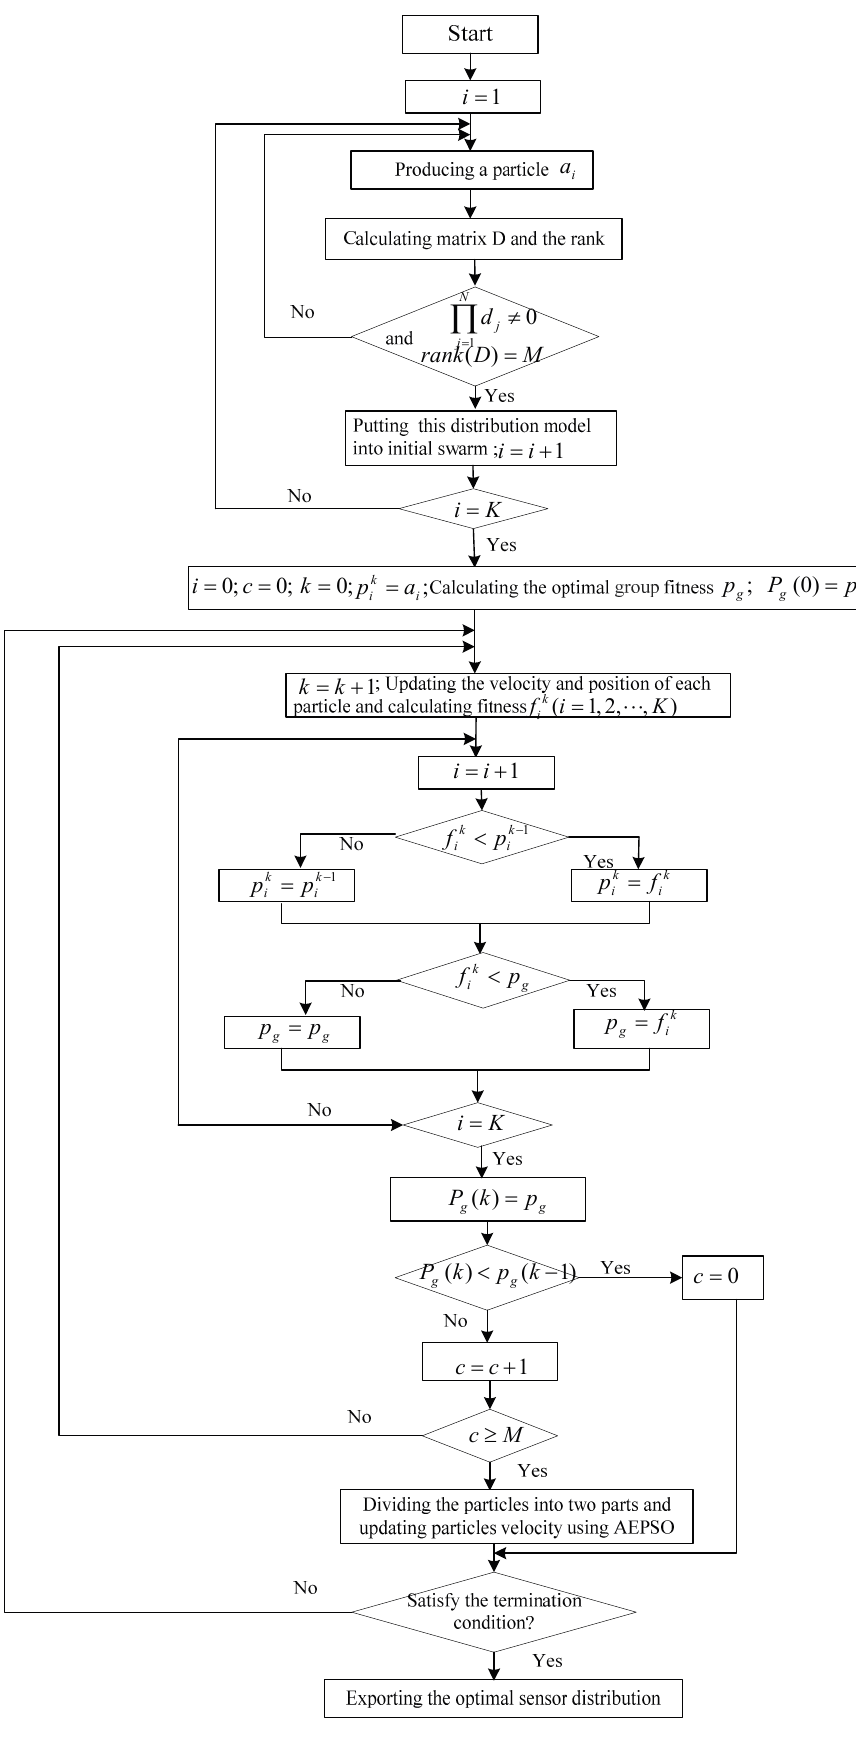
Figure 3. Process of optimizing sensor